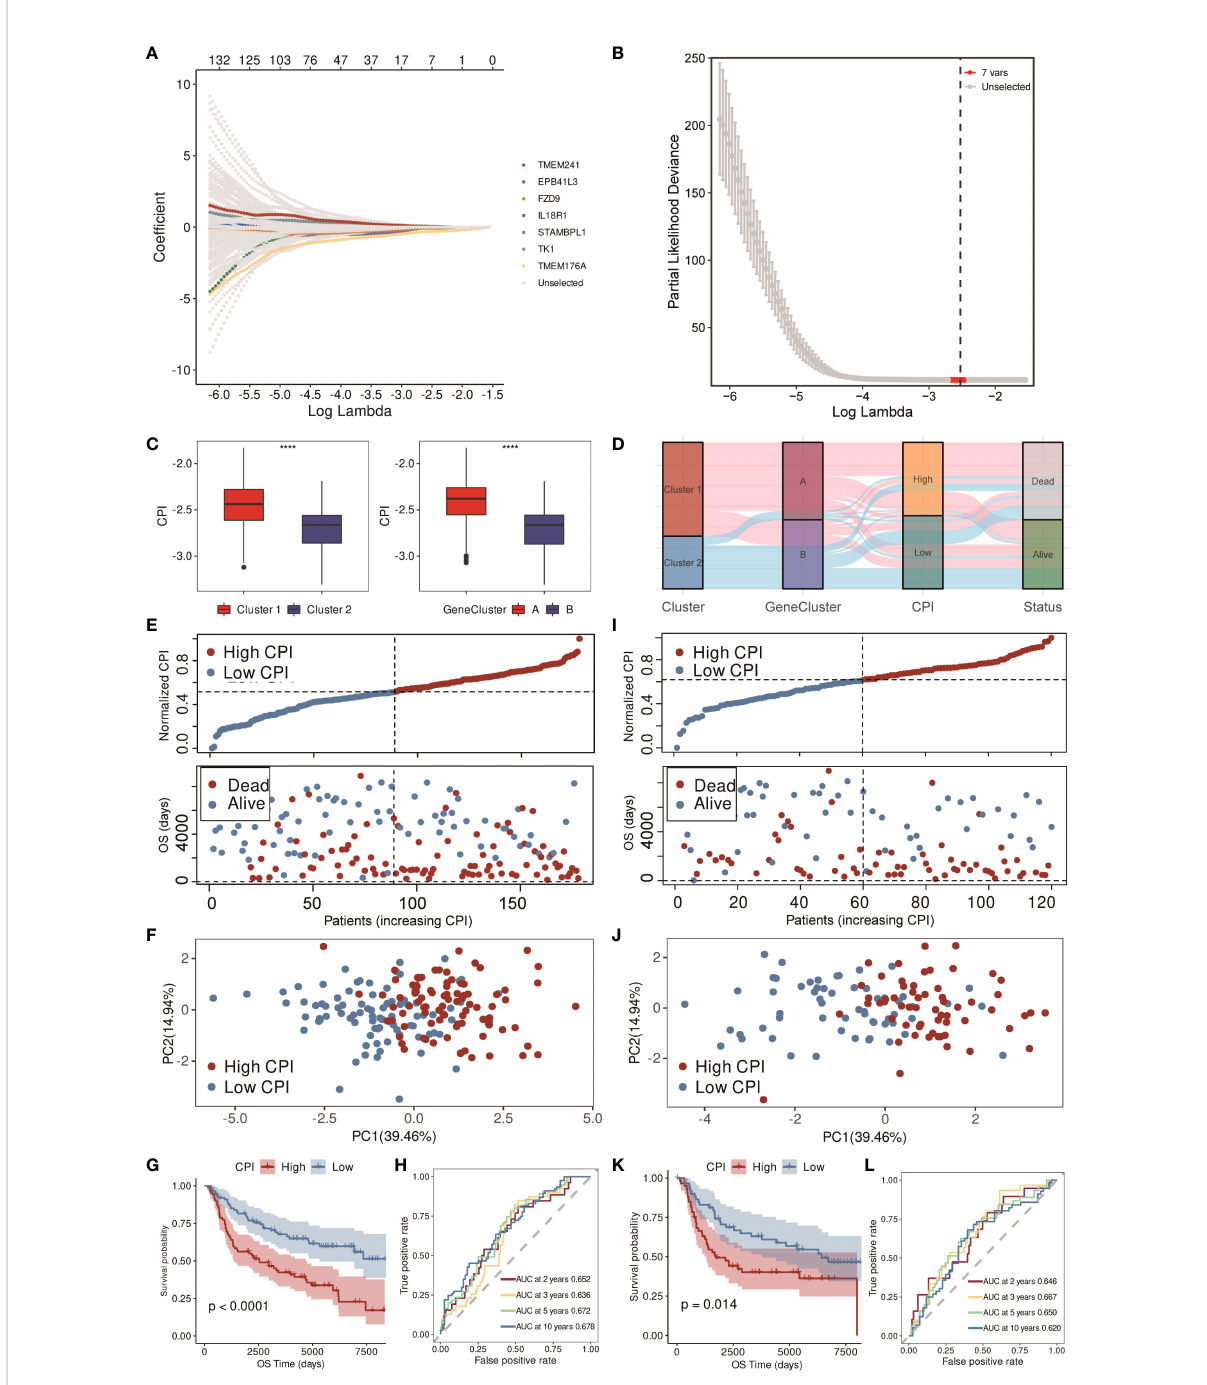
FIGURE 5 Construction and validation of the CPI in the METABRIC cohort. (A) LASSO-Cox regression of the model genes. (B) Cross-validation for the LASSO-Cox regression. (C) Boxplots of the values of CPI between clusters and gene clusters (**** means p < 0.0001). (D) Alluvial diagram of the cluster, gene cluster, CPI group, and survival status. (E) Distribution of adjusted CPI and PCA plot based on the CPI groups in the METABRIC training cohort. (F) PCA plot in the METABRIC training cohort. (G) K-M survival analysis of the patients in the METABRIC training cohort ( fi rebrick: high CPI; steel blue: low CPI). (H) ROC curve analysis according to the 2-, 3-, 5-, and 10-year survival of the AUC value in the METABRIC training cohort. (I) Distribution of adjusted CPI and PCA plot based on the CPI groups in the METABRIC validation cohort. (J) PCA plot in the METABRIC validation cohort. (K) K-M survival analysis of the patients in the METABRIC validation cohort ( fi rebrick: high CPI; steel blue: low CPI). (L) ROC curve analysis according to the 2-, 3-, 5-, and 10-year survival of the AUC value in the METABRIC validation